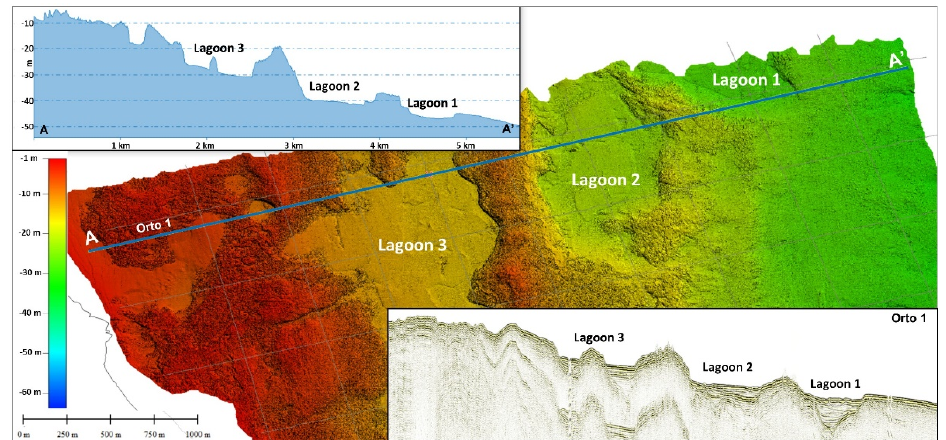
Figure 6. Location of Lagoon 1, Lagoon 2, and Lagoon 3 within the northern sector of the study area and the comparison between the bathymetric and seismic profiles (Orto 1).